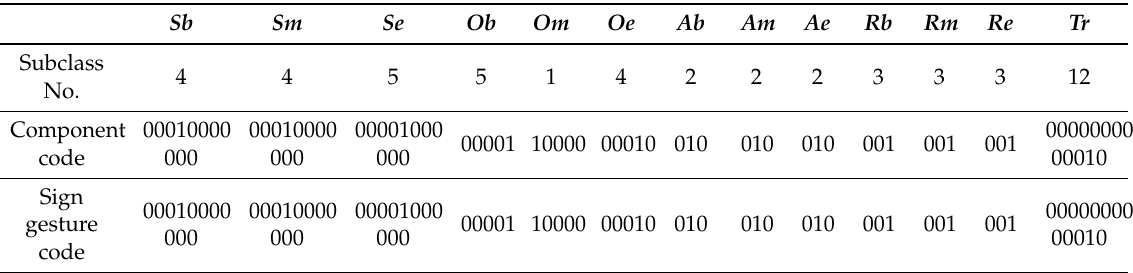
Table 2. An example of gesture